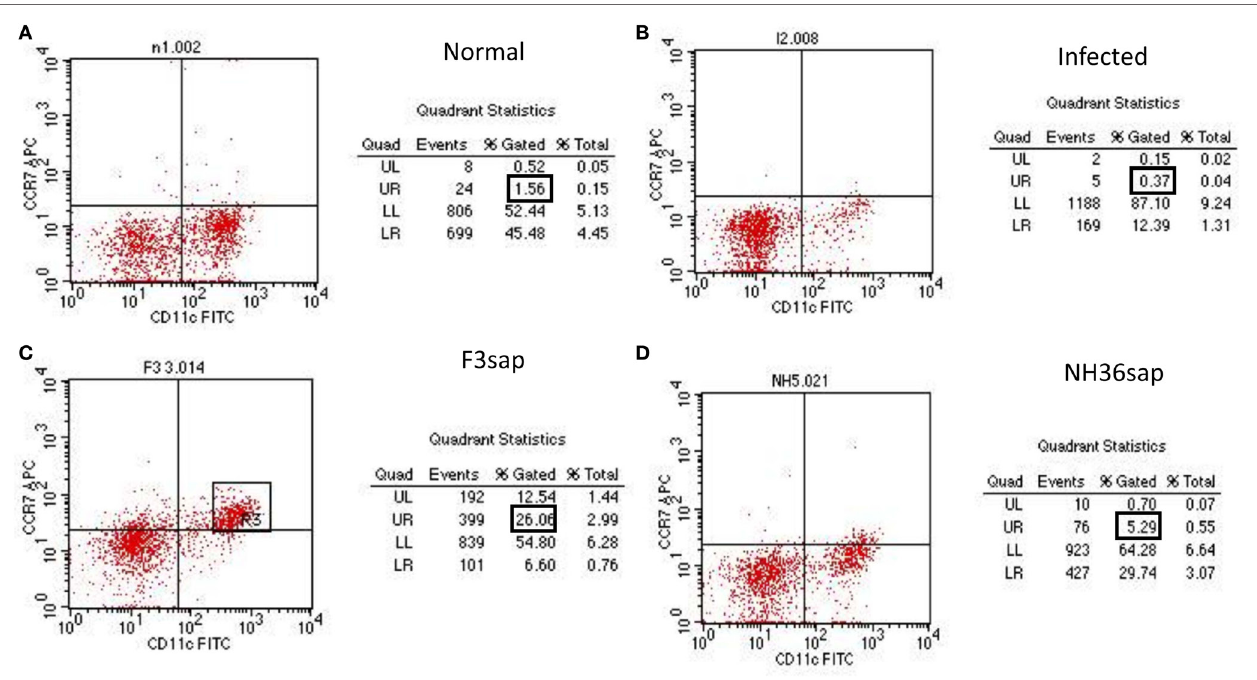
FigUre 3 | Enhanced CCR7 + expression in F3 and NH36-primed dendritic cells (DCs). DCs from normal (a) , infected (B) , and F3 (c) or NH36 (D) vaccinated and challenged C57BL/6 mice were purified and analyzed by flow cytometry. DCs CD11c + populations were gated and analyzed for CCR7 expression using anti-CCR7- allophycocyanin antibody. Results are representative of the individual percentages gated of two experiments ( n = 5 per treatment for each